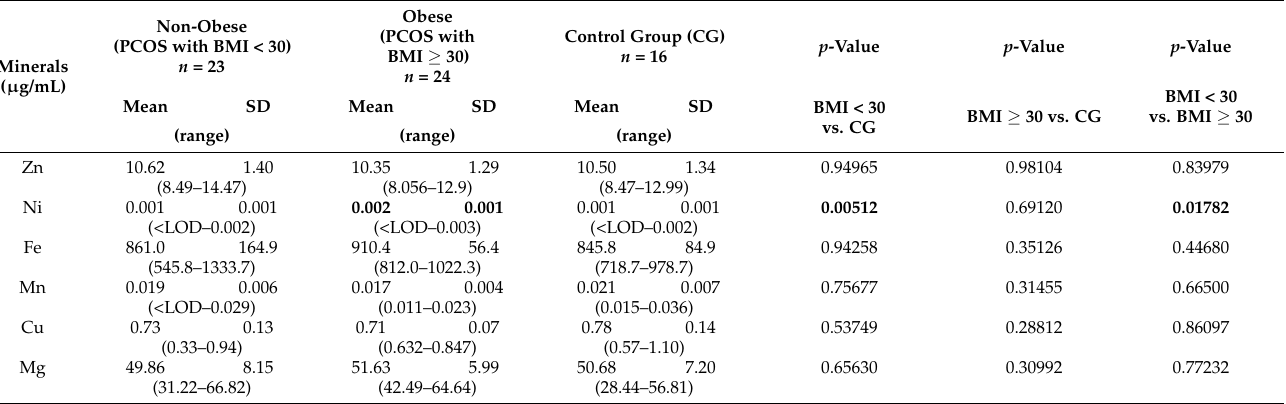
Table 3. Comparison of mineral content in erythrocytes ( µ g/mL) between the groups of obese and nonobese women with PCOS and the control